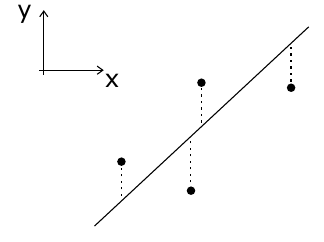
Figure 8: Line fitting done with vertical regression (in y-direction)